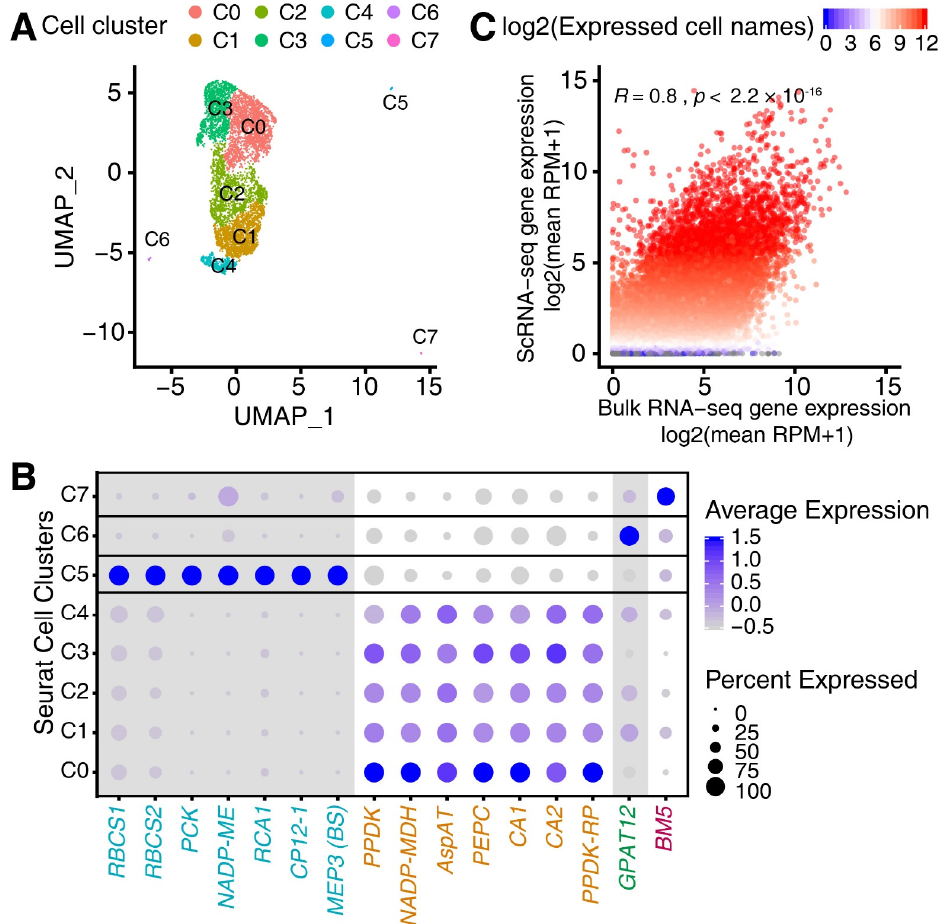
Figure 1. Characterization of scRNA-seq. ( A ) UMAP-based scatterplot showing eight cell clusters for 7354 filtered cells. ( B ) Dotplot showing the average expression levels for 16 cell-type specific genes differentially expressed between M and BS cells and other cell types in the 8 Seurat clusters. The size of the dot represents the ratio of cells with expressed genes out of all cells. Genes with higher expression levels in the BS cells were displayed on a grey background. ( C ) Scatter plot showing the log 2(mean RPM+1) for all genes in the bulk RNA-seq data ( x axis) and scRNA-seq data ( y axis). The color of each dot represents the log 2(cell numbers with expressed genes in the scRNA-seq) . The correlation test was determined using Spearman correlation